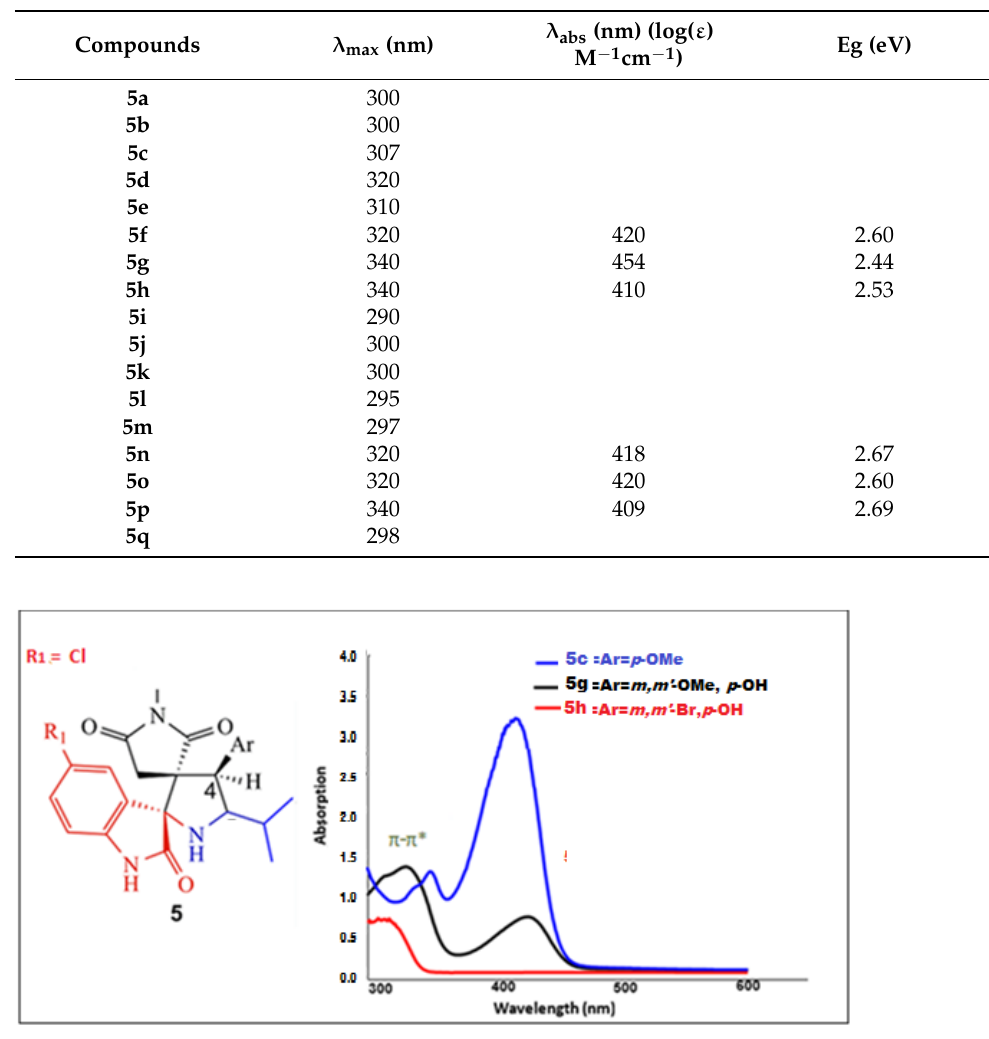
Table 3. UV-vis maxima and optical gap (eV) for series 5